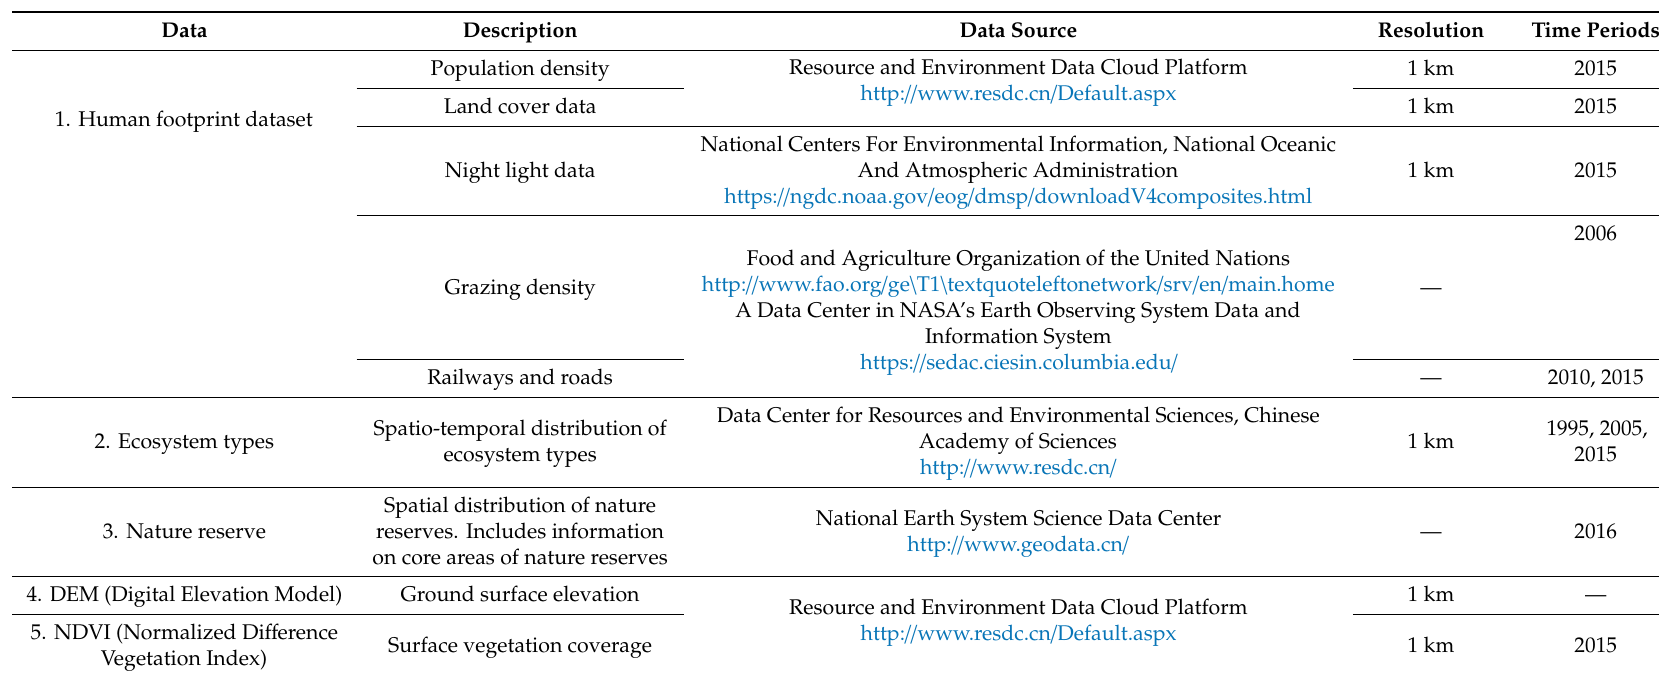
Table 1. Data description and sources. The human footprint dataset includes five spatial data representing human